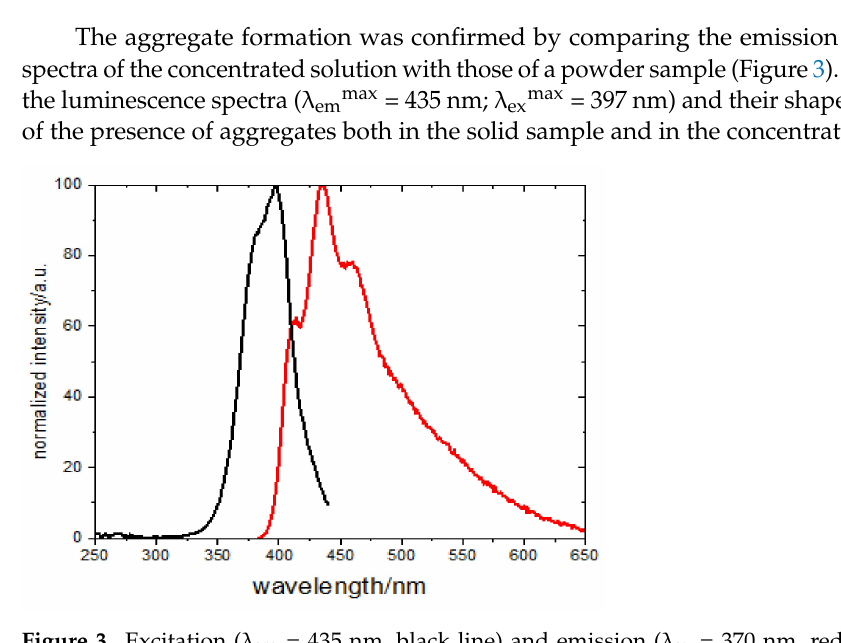
Figure 2. Excitation ( λ em = 356 nm, blue line) and emission ( λ ex = 270 nm, magenta line) spectra of Bpy-SH in diluted dichloromethane solution (1.3 × 10 − 5 M). Excitation ( λ em = 418 nm, black line) and emission ( λ ex = 362 nm, red line) spectra of Bpy-SH in concentrated dichloromethane solution (3.5 × 10 − 2 M).